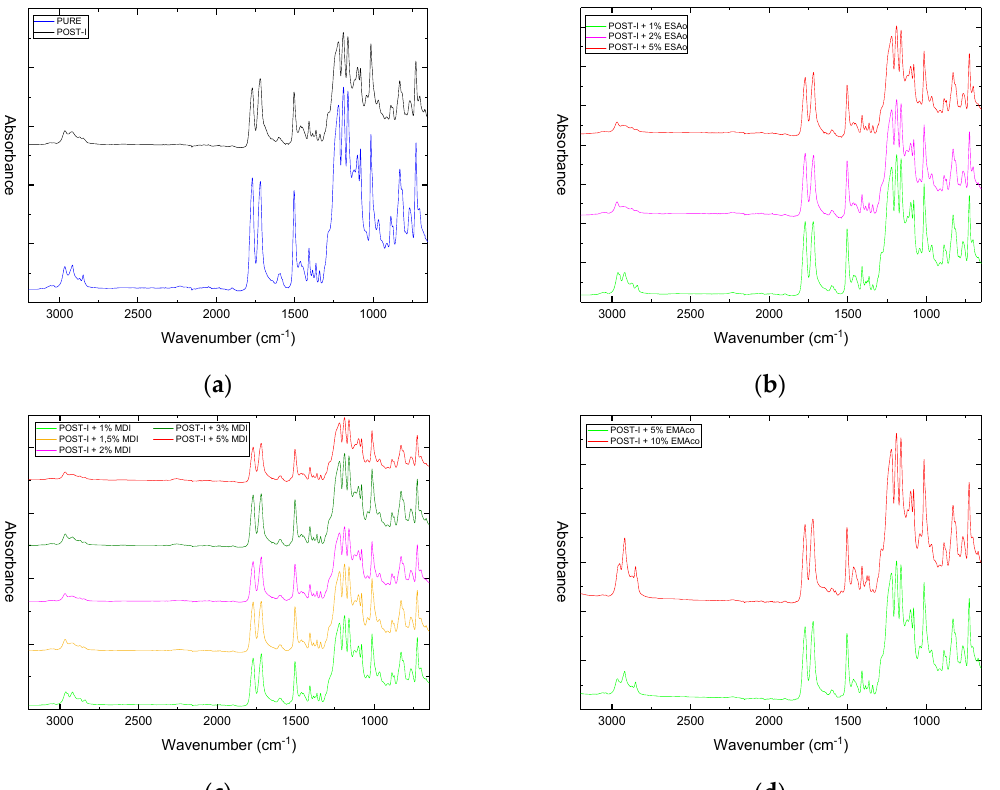
Figure 8. Fourier transform infrared (FTIR) spectra of: ( a ) pure and post-industrial (POST-I) blends without compatibilizers; ( b ) blends with different content of ESAo (1–5 wt %); ( c ) blends with different content of pure MDI (1–5 wt %); ( d ) blends with different content of EMAco (5–10 wt %).